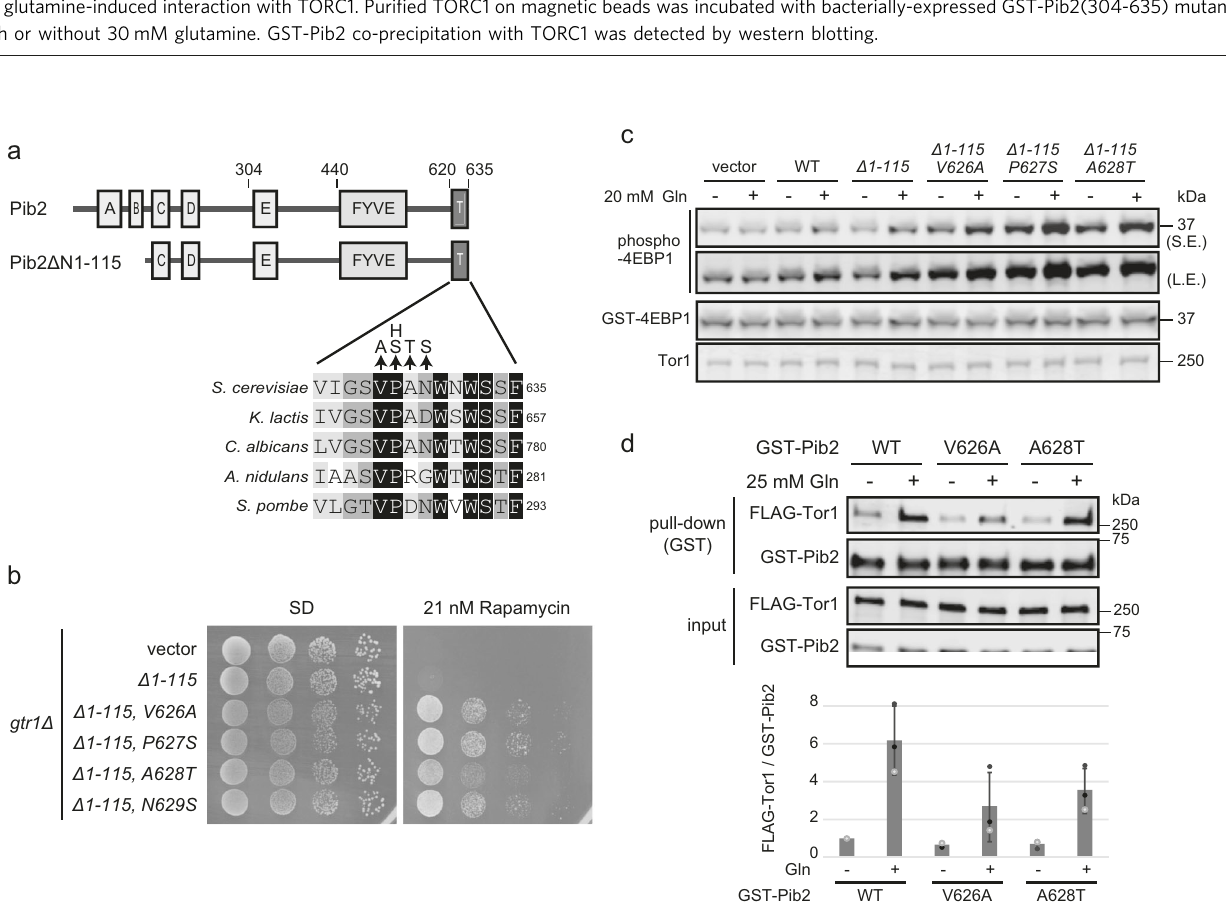
Fig. 2 The Pib2 E motif is required for its glutamine-induced interaction with TORC1. a Schematic diagram of full-length Pib2 and the deletion mutants is used in ( b ). b The E-motif containing the central region of Pib2(304-439) is required for the glutamine-induced interaction between Pib2 and TORC1. Pull-